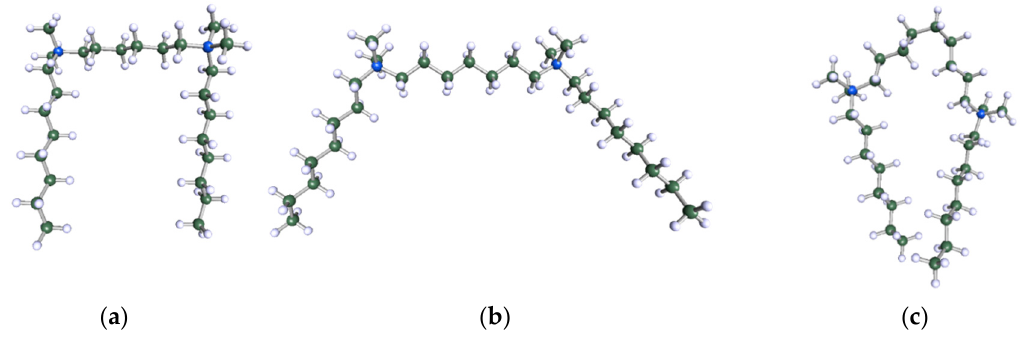
Figure 9. DFT-optimised geometries of the molecules: ( a ) 8-6-8, ( b ) 8-7-8 and ( c ) 8-9-8.